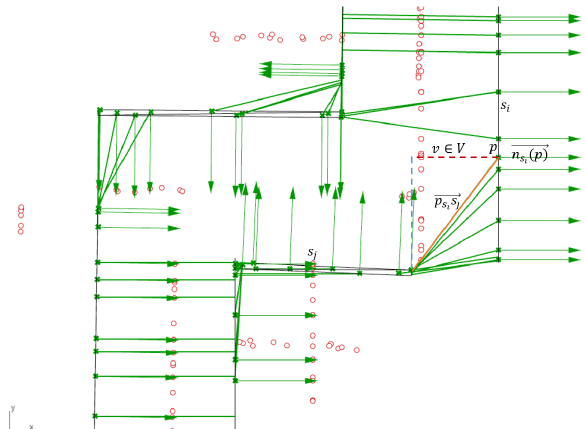
−−−→ ( p ) per p (green ar- n s i −→ ps j connecting p to the nearest point on s j